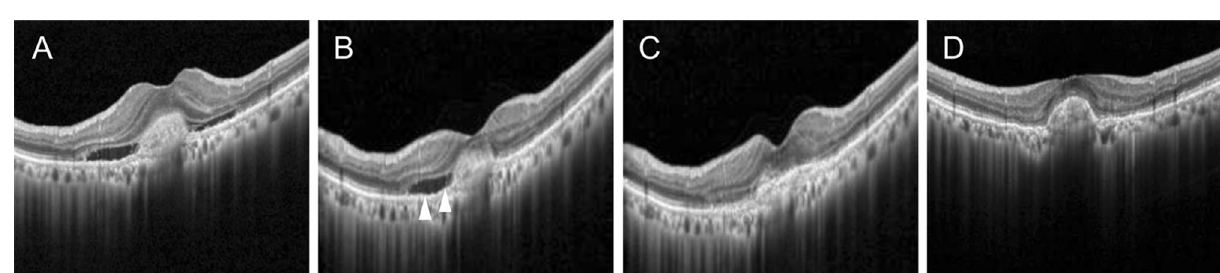
Figure 4. Performance of the artificial intelligence model in predicting residual subretinal fluid ( A ) and intraretinal fluid ( B ) after three loading injections of either ranibizumab or aflibercept (n = 98). The sensitivity and specificity, are noted to be 0.500 and 0.837 for SRF and 0.455 and 0.897 for IRF, respectively. The performance of the human examiners was not evaluated in this analysis.